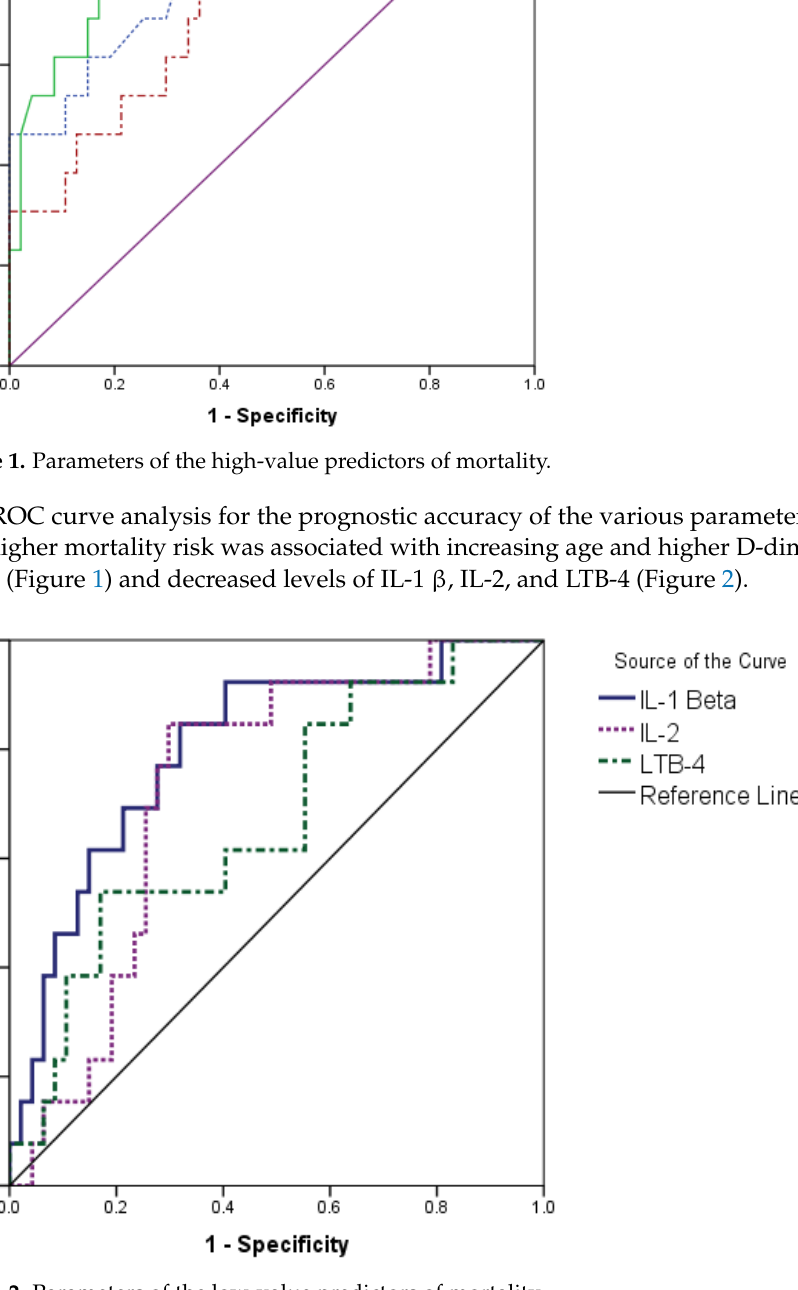
Figure 2. Parameters of the low-value predictors of mortality.